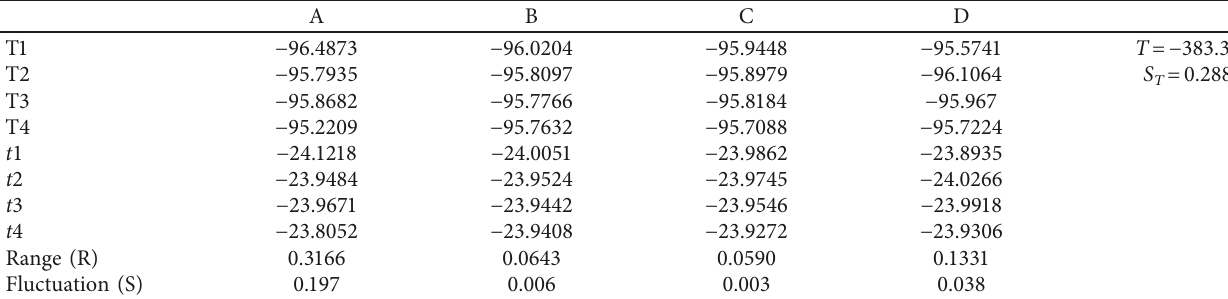
Table 7: Data statistics of SNR calculation results.